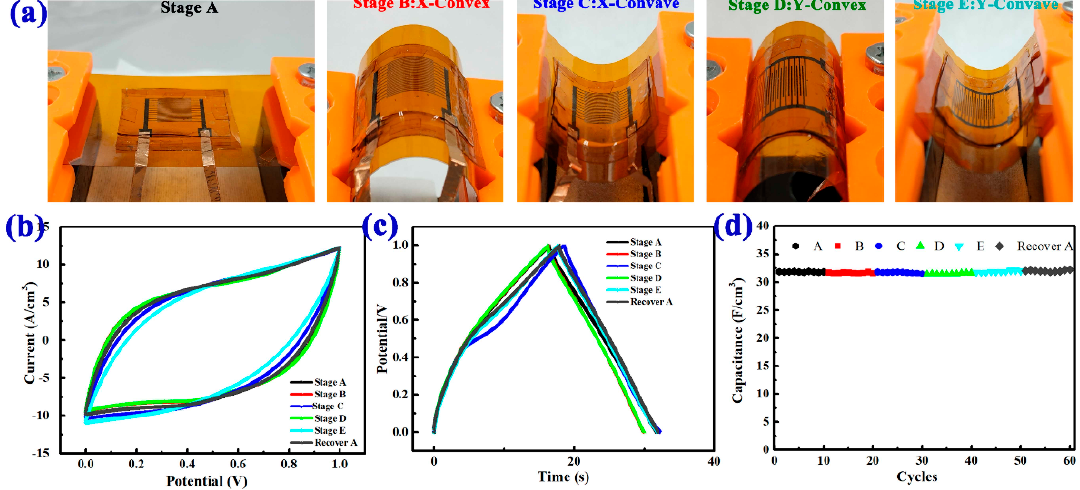
Figure 4. ( a ) Photos of a MSC at different bending states; ( b ) CV curves at 100 mV/s in straight and different bending states, respectively; ( c ) charge/discharge curves at a current of 2 A/cm 3 in straight and different bending states, respectively; ( d ) capacitance performance under the different bending states.